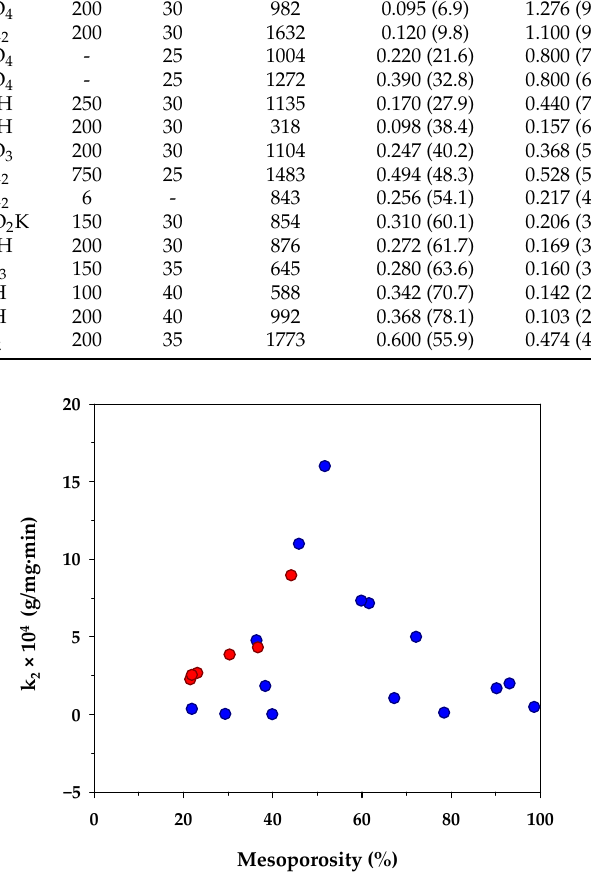
Figure 3. Effect of percent mesoporosity in activated carbons on the rate constant ( k 2 ) of the pseudo- second-order kinetic model. The red circle symbols represent the results from the present study and the blue circle symbols are those from other investigators (see references in Table 6).